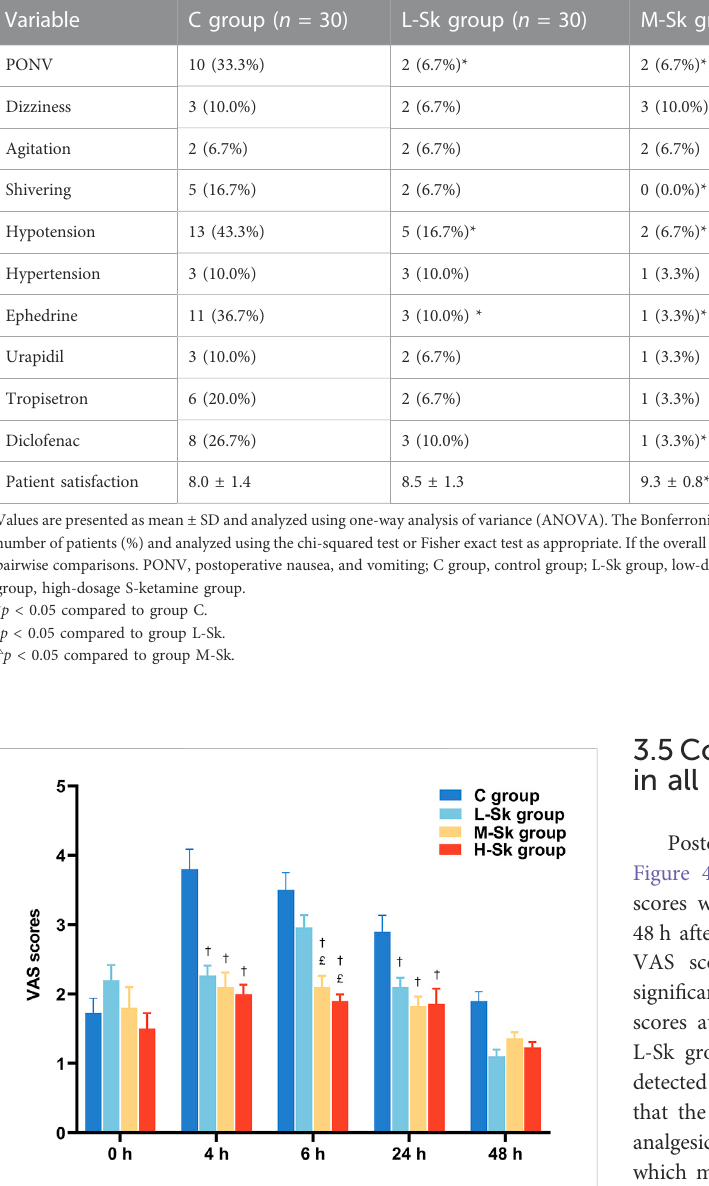
FIGURE 4 Comparison of the VAS scores for patients in all groups. 0 h, the endofthesurgery; 4 h,4 hafterthesurgery; 6 h,6 hafterthesurgery; 24 h, 24 h after the surgery; 48 h, 48 h after the surgery; C group, control group; L-Sk group, low-dosage S-ketamine group; M-Sk group, middle-dosage S-ketamine group; H-Sk group, high-dosage S-ketamine group. † p < 0.05 compared to the C group. £ p < 0.05 compared to the L-Sk group. ‡ p < 0.05 compared to the M-Sk